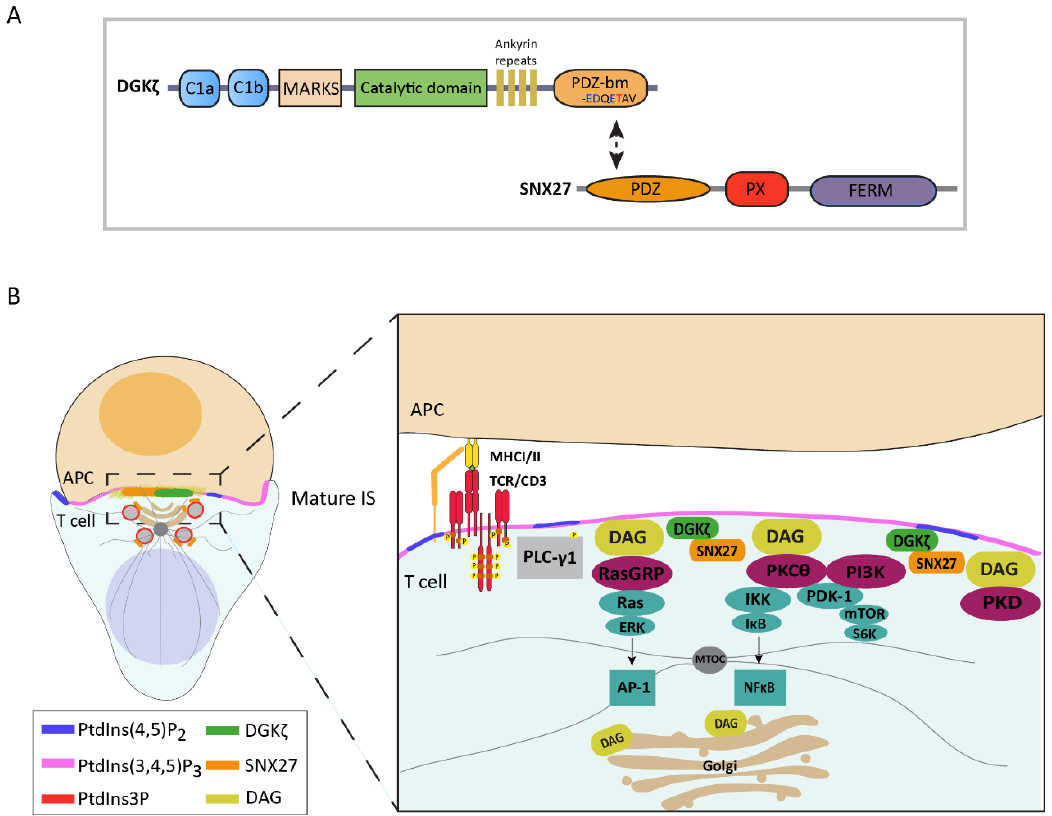
Figure 4. SNX27 participates in the regulation of DAG metabolism at the IS through interaction with DGK ζ . ( A ) DGK ζ and SNX27 proteins interact in a PDZ-dependent manner. The high-a ffi nity DGK ζ C-terminal sequence EDQETAV with possible phosphorylation sites (red) and positively charged amino acids (blue) is indicated. ( B ) Engagement of antigen–TCR triggers PLC- γ 1 activation, resulting in DAG production and its accumulation at the IS. Likewise, SNX27 and the DAG-negative regulator DGK ζ translocate to the IS simultaneously with PtdIns(3,4,5)P 3 and DAG generation. SNX27 sustains the stability and localization of this kinase, facilitating the regulation of DAG and its downstream signaling